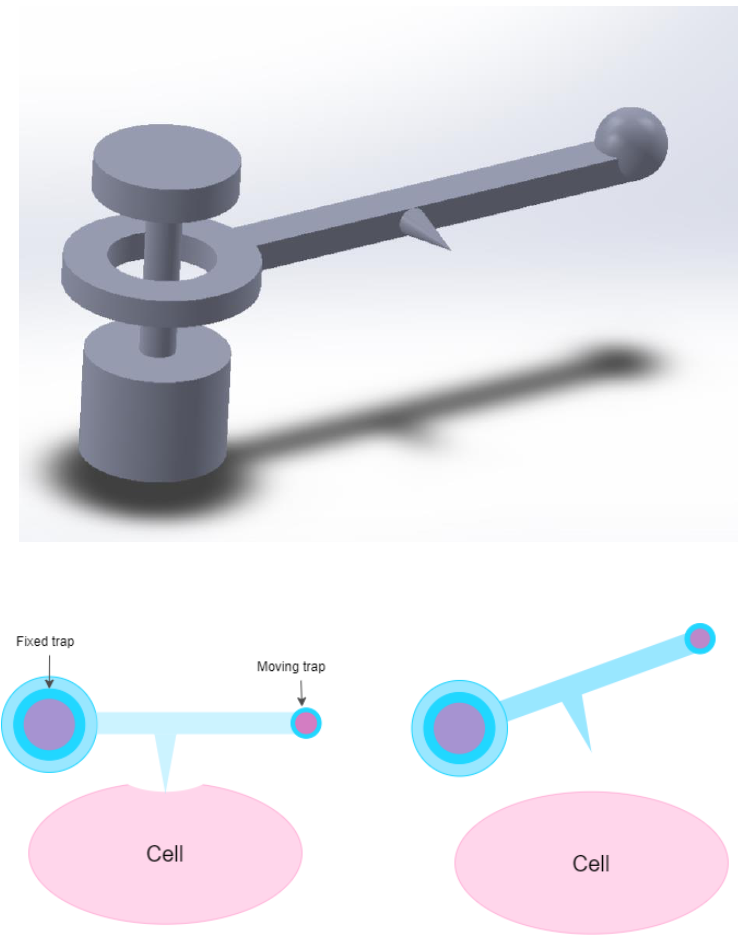
Figure 7. A free-floating microrobot, such as this lever, equipped with a sharp tip, could be used to apply amplified forces for measuring cell membrane stiffness. At least two traps are necessary for this, one fixed trap to hold the microlever in place near the cell and another to move the lever